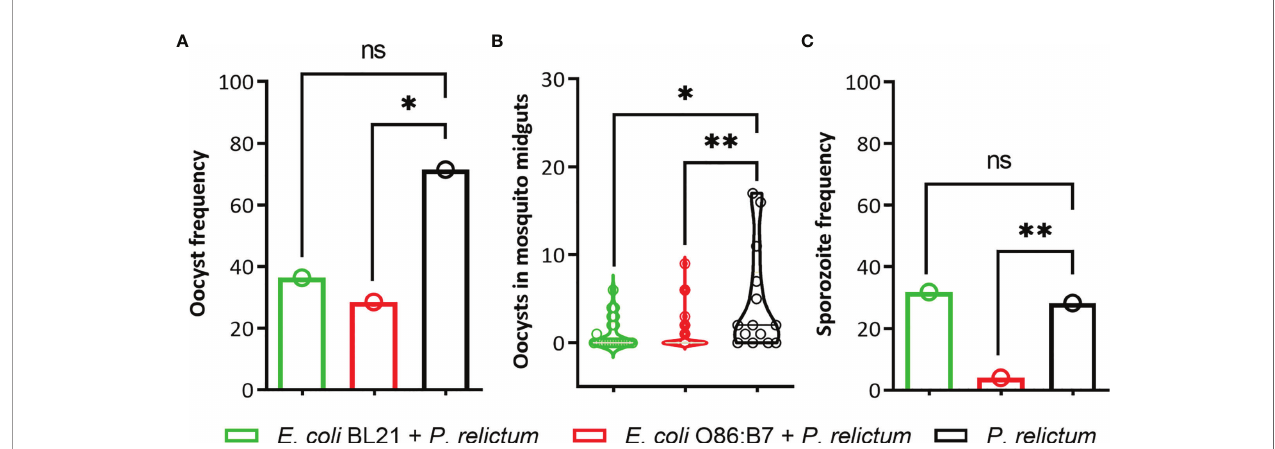
FIGURE 9 | Impact of anti-microbiota vaccines on P. relictum development in infected mosquitoes. Three groups of P. relictum-infected birds were used as infection donors for mosquitoes. One of the groups was vaccinated with E. coli BL21, the other with E. coli O86:B7, and a third group was a control (only infection). (A) The percentage of mosquitoes in which at least one oocyst was found in the midgut by microscopy and compared between the groups was measured. (B) The number of oocysts in the midgut of P. relictum-infected mosquitoes was calculated and compared between the groups. (C) The percentage of mosquitoes in which sporozoites were detected in salivary glands by microscopy or PCR was measured and compared between the groups. The parameters were compared between groups by Fisher ’ s exact test with Bonferroni correction (oocyst and sporozoite frequency) and the Mann-Whitney U test (number of oocyst). (*p <0.05; **p <0.001; ns, not signi fi cant; n = 14-53 mosquitoes per